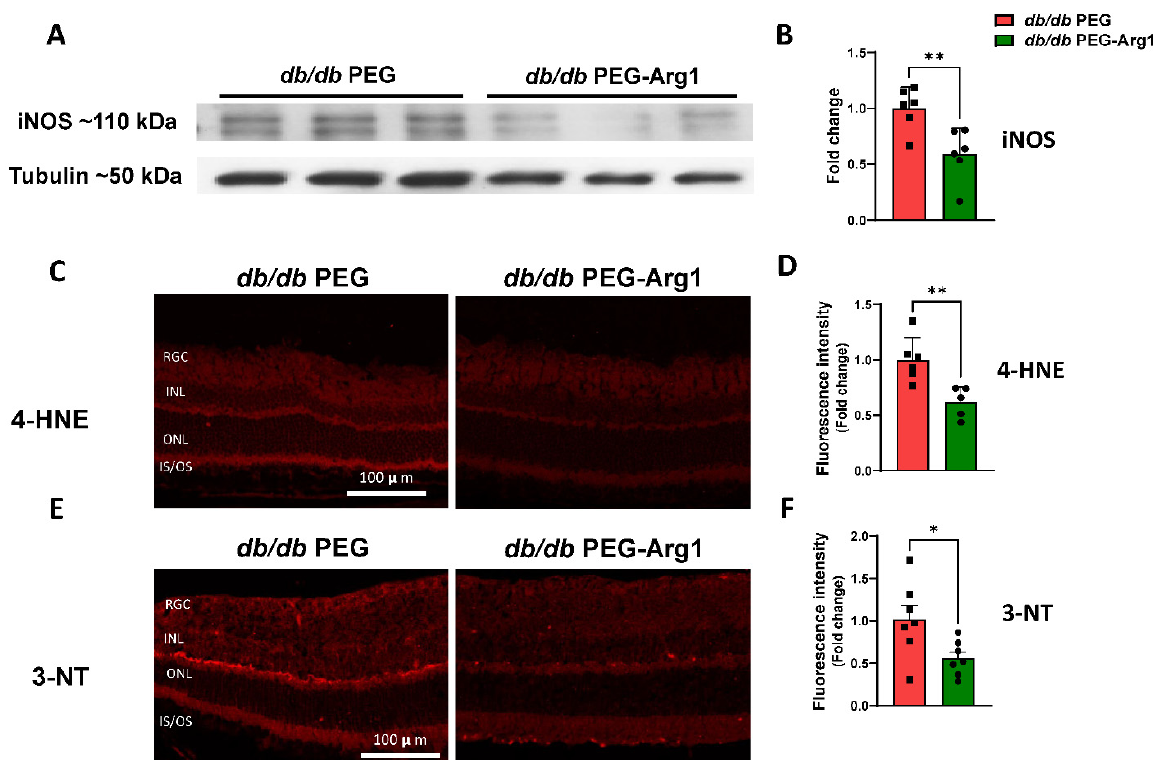
Figure 4. PEG-Arg1 treatment reduces oxidative/nitrative stress in db/db retinas. ( A ) Representative Western blots of retinal iNOS levels with ( B ) quantification, demonstrating significant reductions in iNOS protein expression in PEG-Arg1-treated db/db mice compared with the PEG-treated controls (n = 6/group, ** p < 0.01). ( C , E ) Representative immunofluorescent labeling at 10 × of frozen retina sections from PEG-Arg1- or PEG-treated db/db mice with 3-NT, respectively. ( D , F ) Fluorescence intensity quantification of oxidative stress, showing significant reductions in 4-HNE and 3-NT in retinas of PEG-A1-treated db/db mice (n = 5–6/group, * p < 0.05, ** p < 0.01).